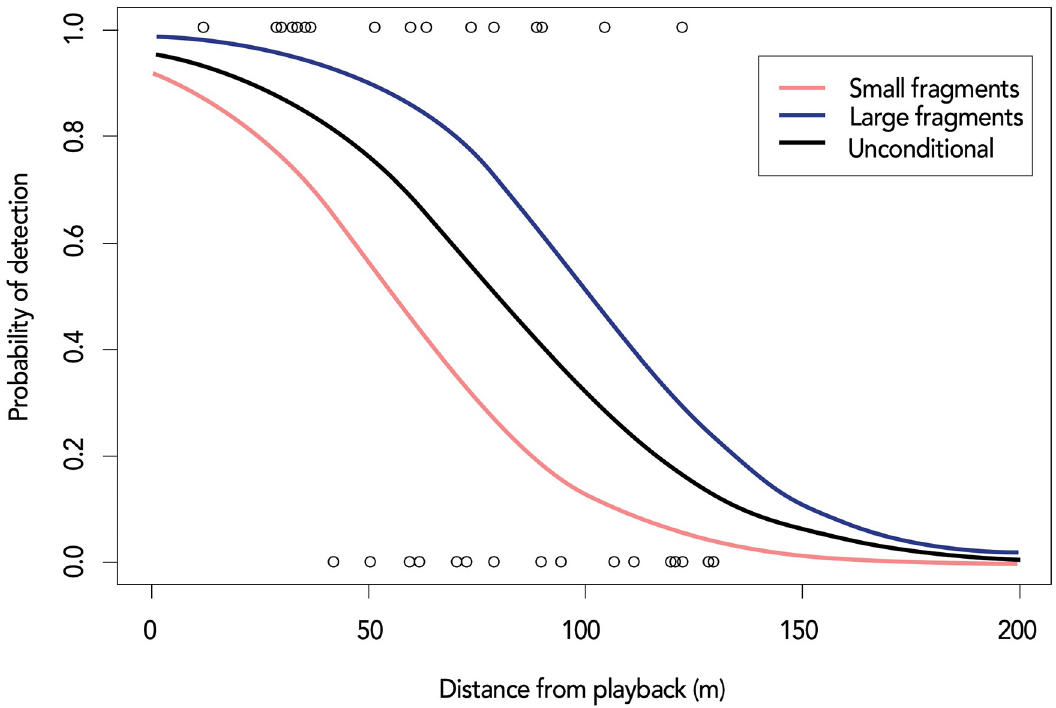
Fig 3. Plot of response against distance of GLT group from the playback point for 40 trials. The range of values along the Y-axis, 1 and 0, represent probability of detecting GLTs during the playback trial. Also shown is the estimated probability of detection as a function of distance from the playback point (black line), and the estimated probability of detection as a function of distance from the playback point conditional to the fragment size (Small fragment ( < 60 ha) = red line; Large fragment (3,606 ha, 5,584 ha) = blue line).